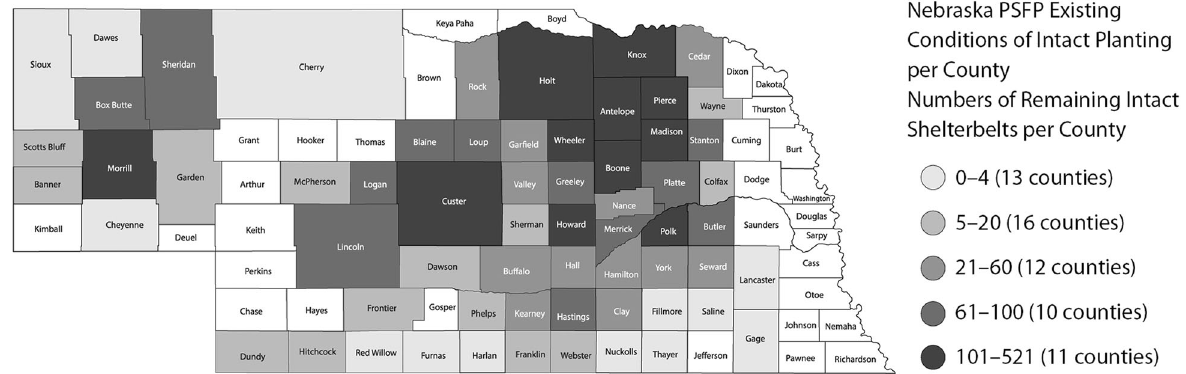
Fig. 10 Nebraska PSFP Existing Conditions of Intact Plantings per County. Map illustrating the number of intact shelterbelts per county in 2016 (Source: the